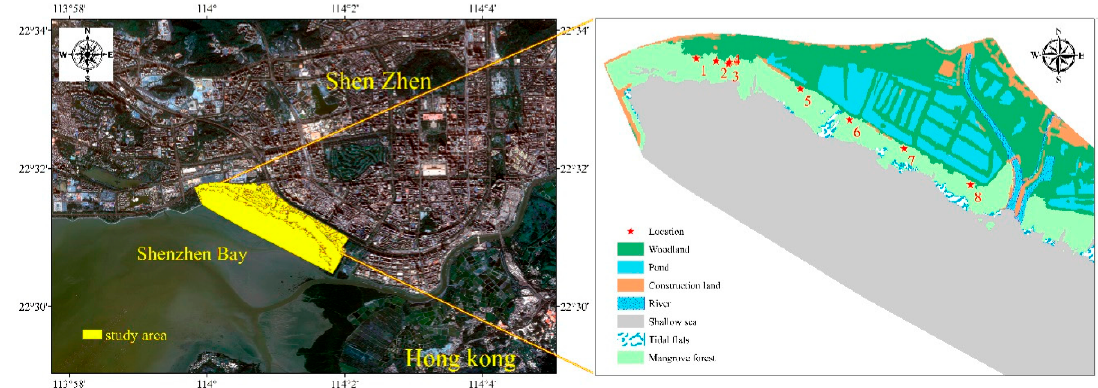
Figure 1. Map of the study area showing the sampling locations.